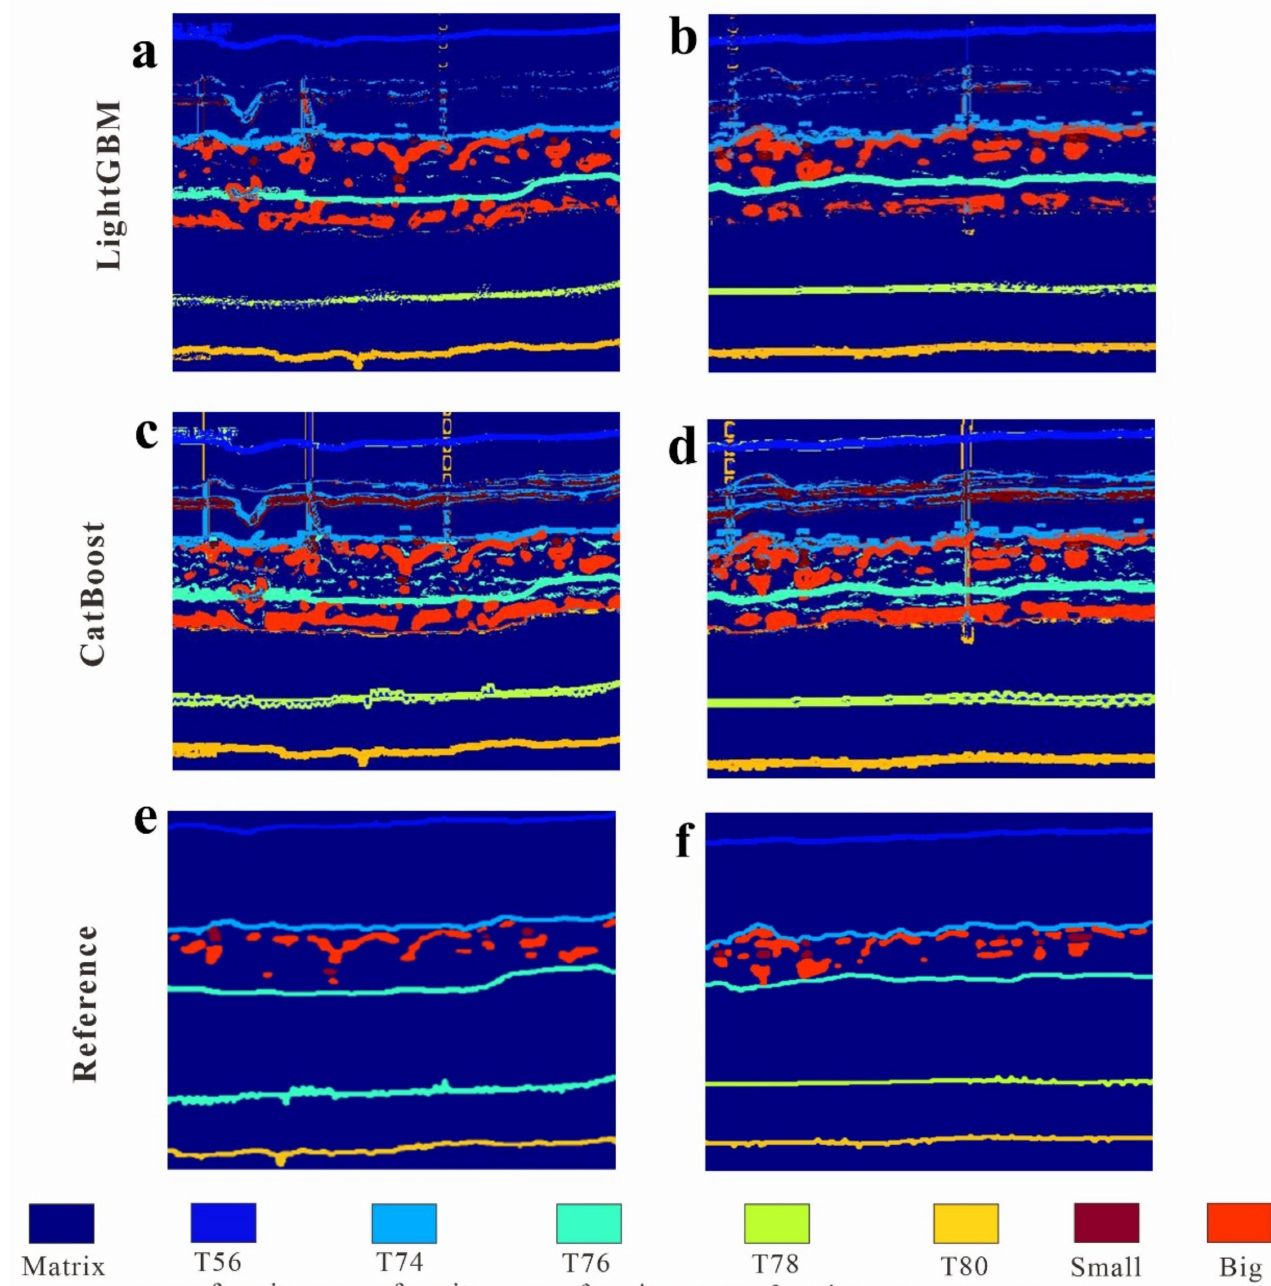
Figure 9. Comparison of images predicted by LightGBM ( a , b ), CatBoost ( c , d ), and reference images 7480 ( e ) and 2530 ( f ) in case